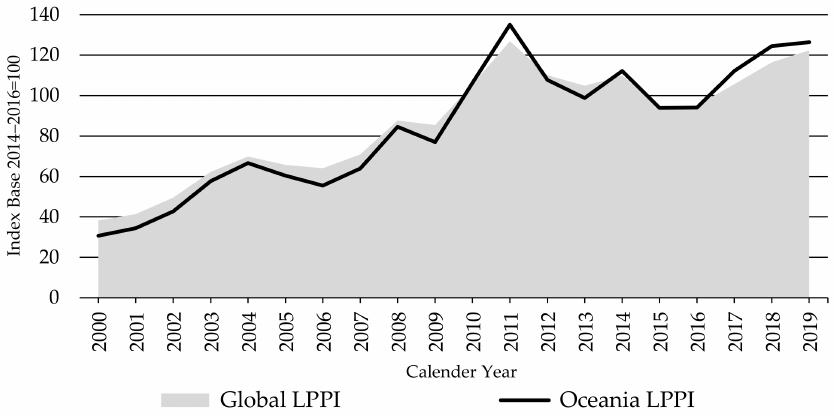
Figure 9. The Global and Oceania Lambs Producer Price Indices LPPIs, source: own